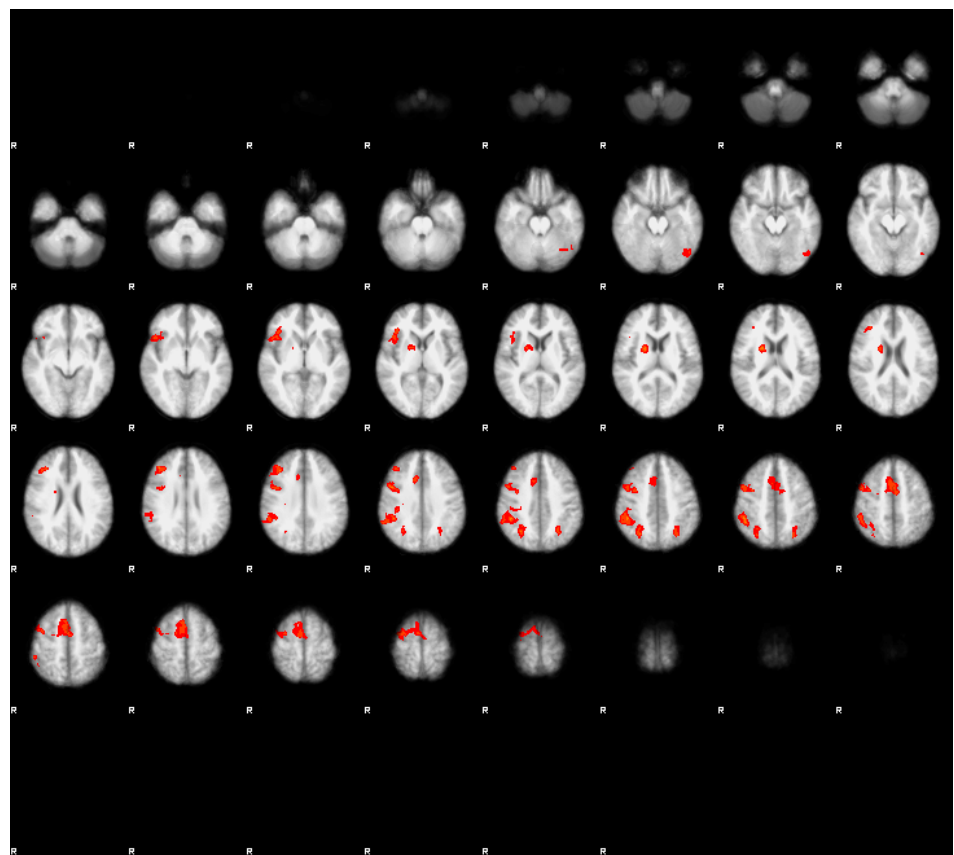
Figure 3. The main effects of the task in the fatigued condition. Images were thresholded at Z > 3.1. Note the more extensive activations in the right hemisphere of the brain (denoted by the letter R) in the posterior parietal cortices, supplementary motor area (SMA), premotor cortex, and dorso-lateral prefrontal cortex in comparison to the rested condition (see Figure 2). Activation in the middle temporal cortex maintained its lateralization in the left hemisphere. Table 4. Main effects—fatigued condition. The table lists the approximate anatomical details of the suprathreshold clusters. Z-score represents the maximum Z value within the given cluster. X, Y, and Z values denote MNI coordinates of the maximum Z-value voxel. Cluster volume is given as a voxel count. Anatomical labels were identified using the Harvard- Oxford Cortical and Subcortical Atlases, Juelich Histological Atlas, and Talairach Daemon Labels as provided by FSL software. The characters within parentheses accompanying the anatomical labels indicate the hemisphere—left or right. Cluster Z Volume Supplementary motor area (R), precentral gyrus (R), middle frontal gyrus (R), medial frontal gyrus (R)